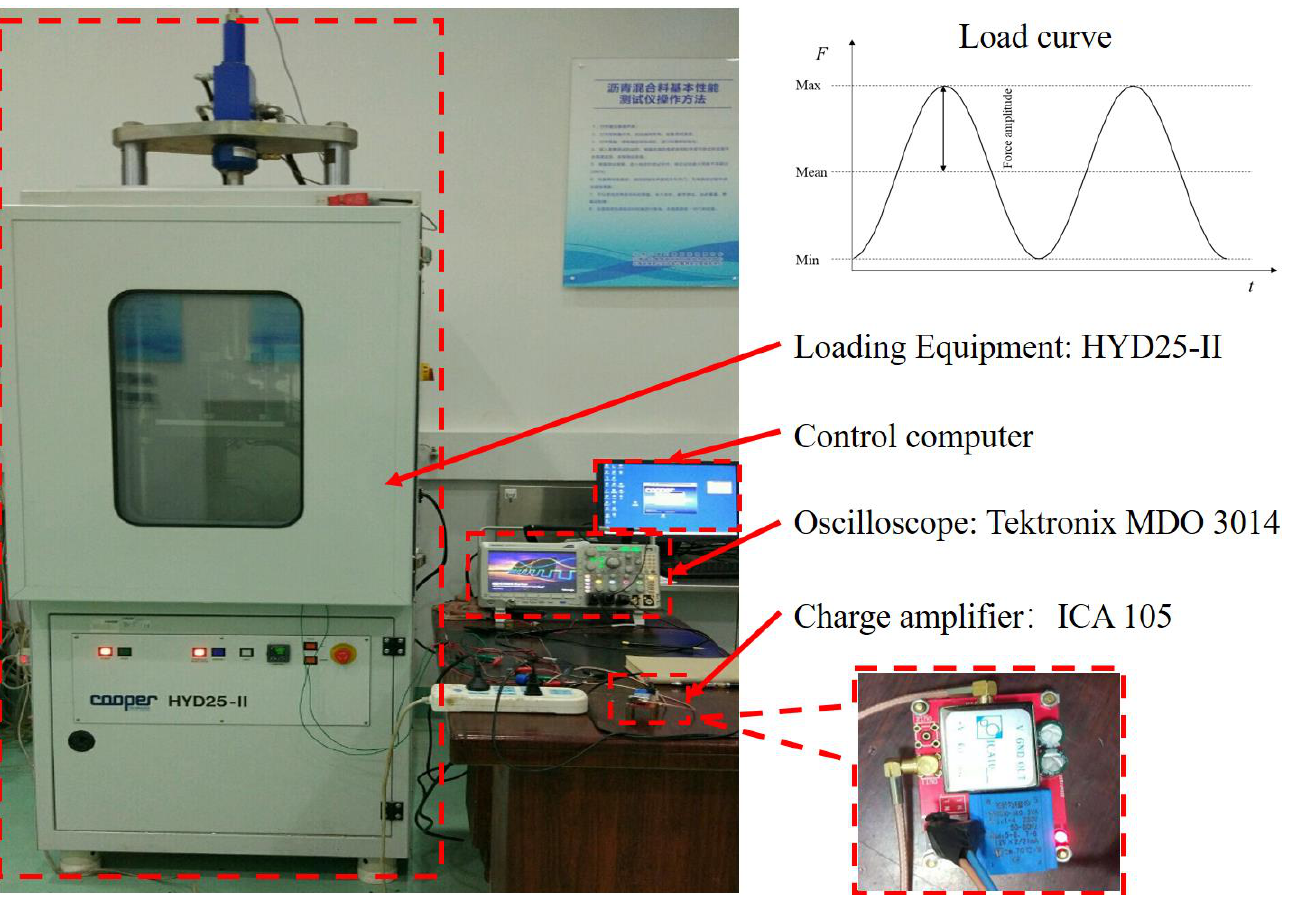
Figure 4. The test system.